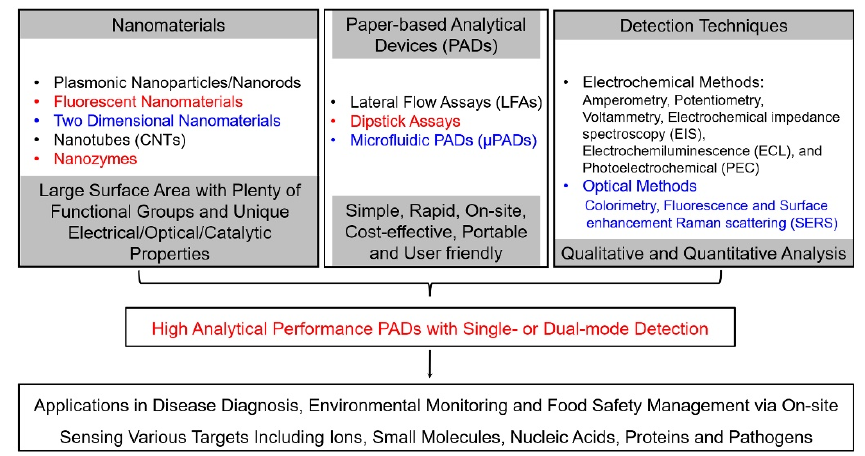
Figure 2. Outline of nanomaterial-based paper-based analytical devices.